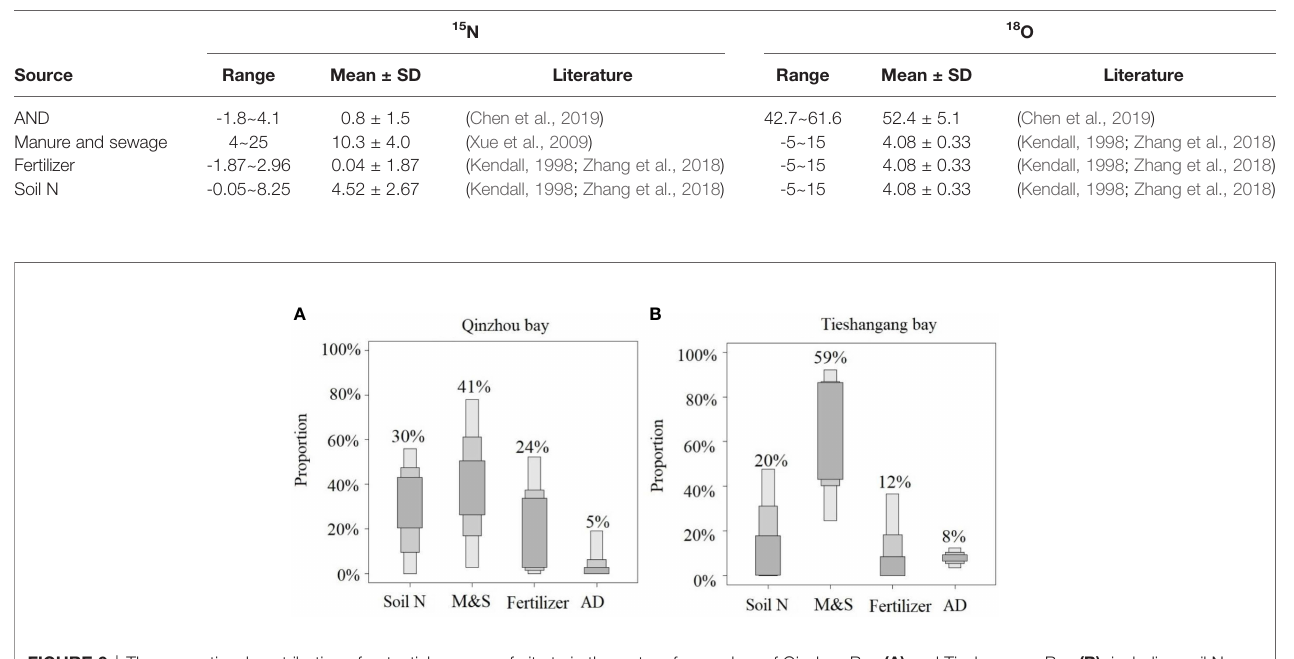
FIGURE 9 | The proportional contribution of potential sources of nitrate in the water of upper bay of Qinzhou Bay (A) and Tieshangang Bay (B) , including soil N, manure and sewage (M&S), fertilizer, and atmospheric deposition